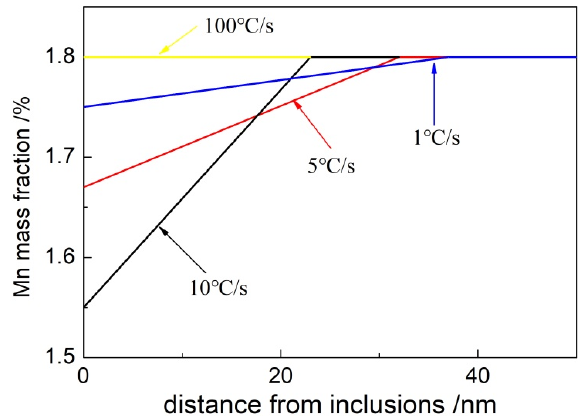
Figure 9. Calculation results of Mn concentration around inclusions.